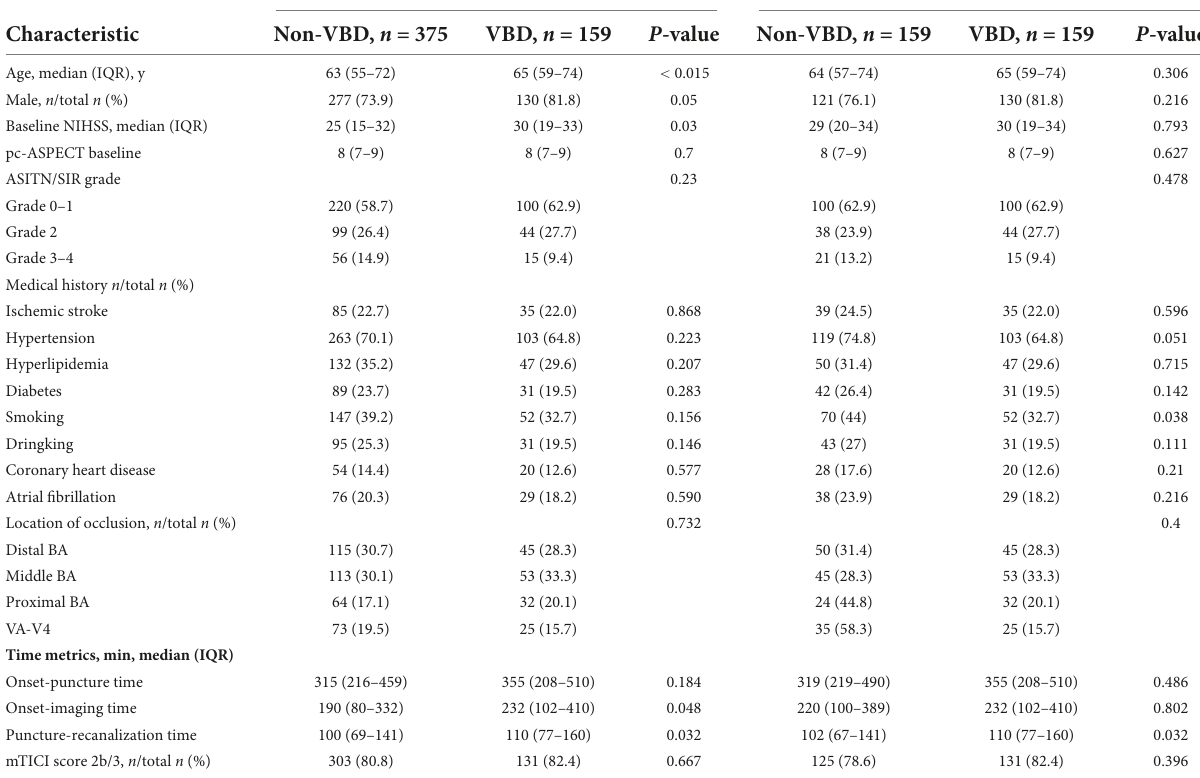
TABLE 1 Baseline characteristics of patients with or without VBD.